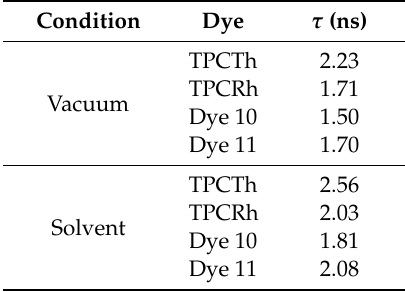
Table 8. The fluorescent lifetime (ns) of TPCTh, TPCRh, dyes 10 and 11.